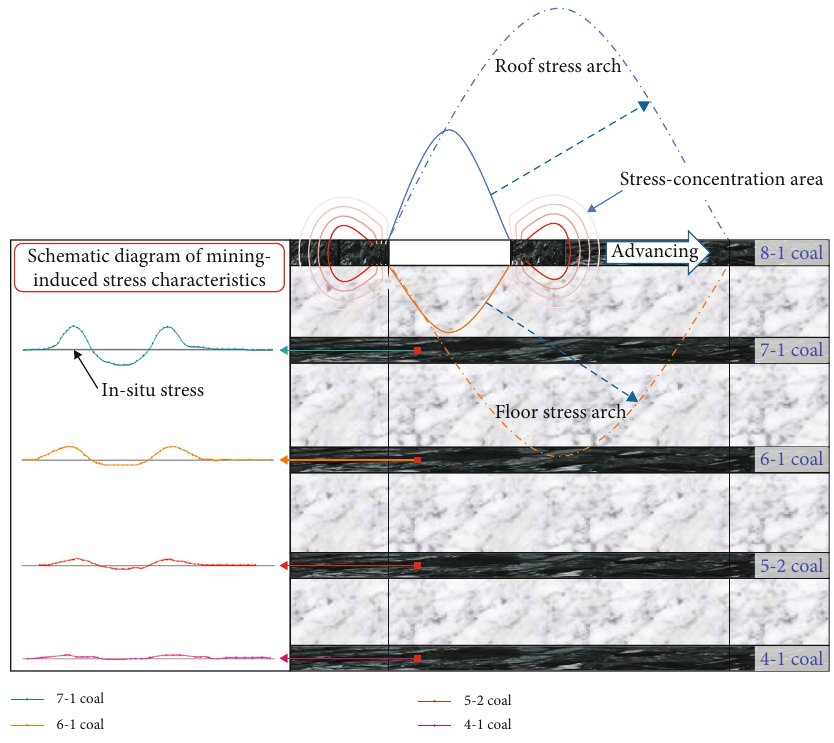
Figure 10: Evolution characteristics of the vertical stress fi eld during the single 8-1 coal seam mining.